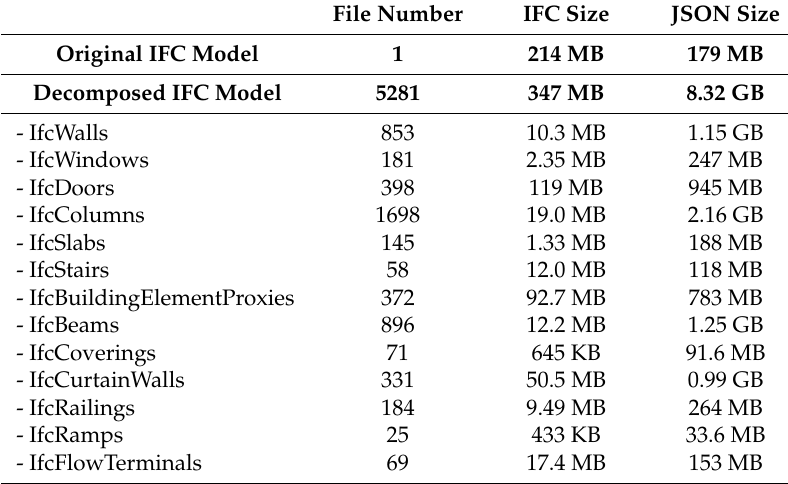
Table 2. Intermediate disk usage for each IFC types during the IFC decomposition step. The original IFC file size was 214 MB and the JSON file size was 179 MB.